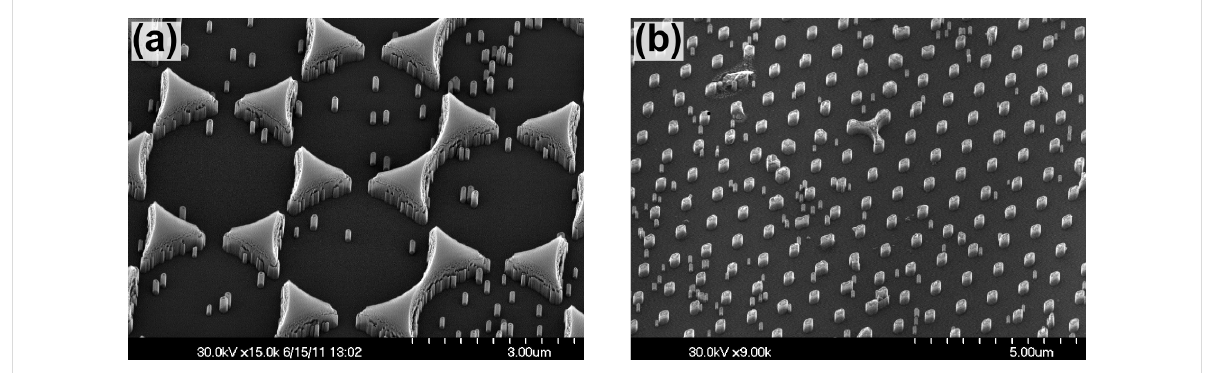
Figure 6: SEM micrographs of arrays of triangular mesas etched into the quartz substrate. Spheres of 3 μ m diameter (a) and 1 μ m (b) were used for the production of the Cr mask. The pattern of the etched mesas in the right image was obtained from a Cr deposition over a double layer of spheres. The depth of the quartz structures was (a) 500 nm and (b) 300 nm. The thickness of the Cr film of the mask was (a) 30 nm and (b) 18 nm.